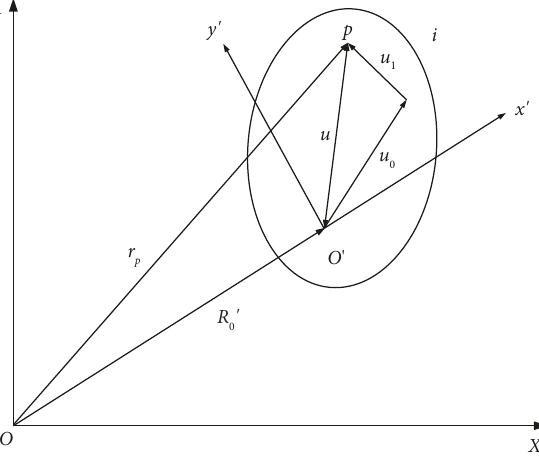
Figure 3: Point structure position vector of a large wind